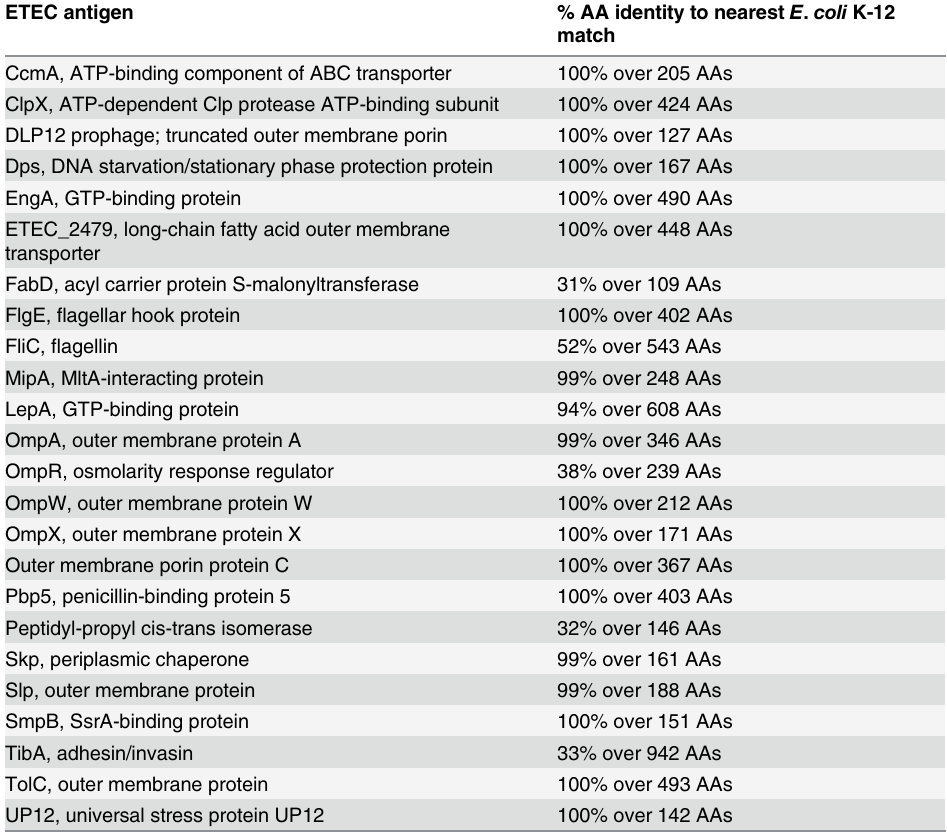
Table 2. ETEC H10407 proteins enriched in membrane protein preparations from WT vs. Δ gspE . ETEC